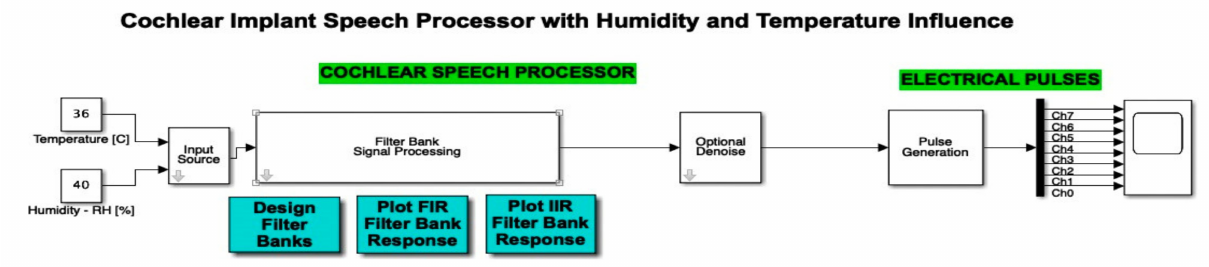
Figure 8. Simulink integration of the temperature and humidity. Two constants are used in order to compute the atmospheric attenuation function.